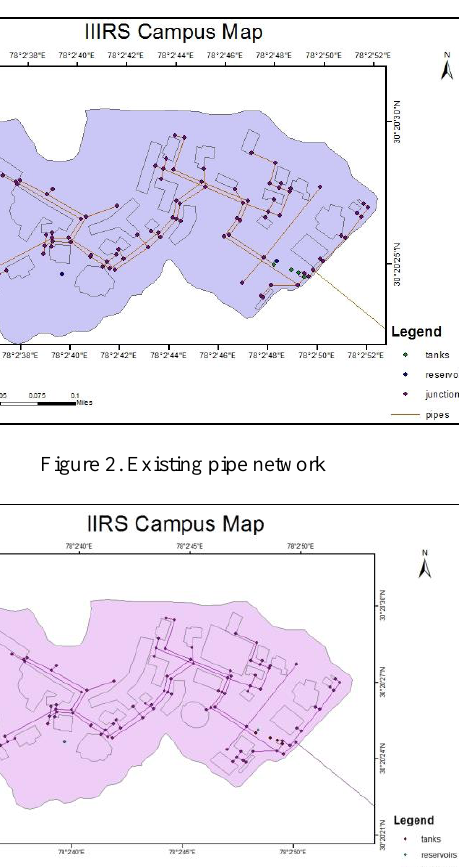
Figure 1. Study area IIRS campus and colony